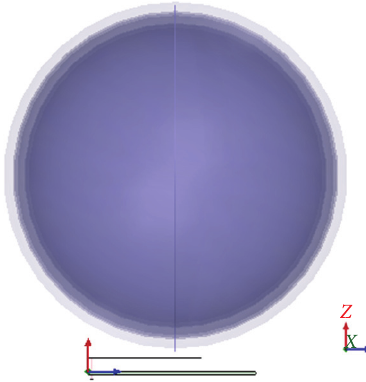
F 16: Six-layer human head model with PIFA antenna.